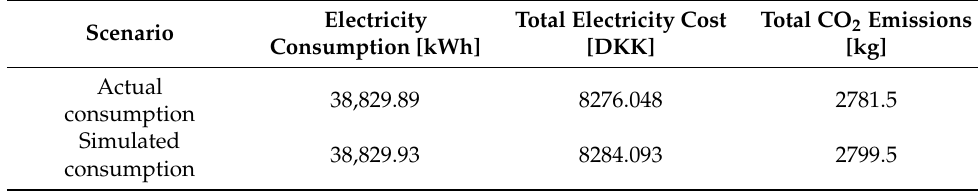
Table 8. Baseline-operation results.